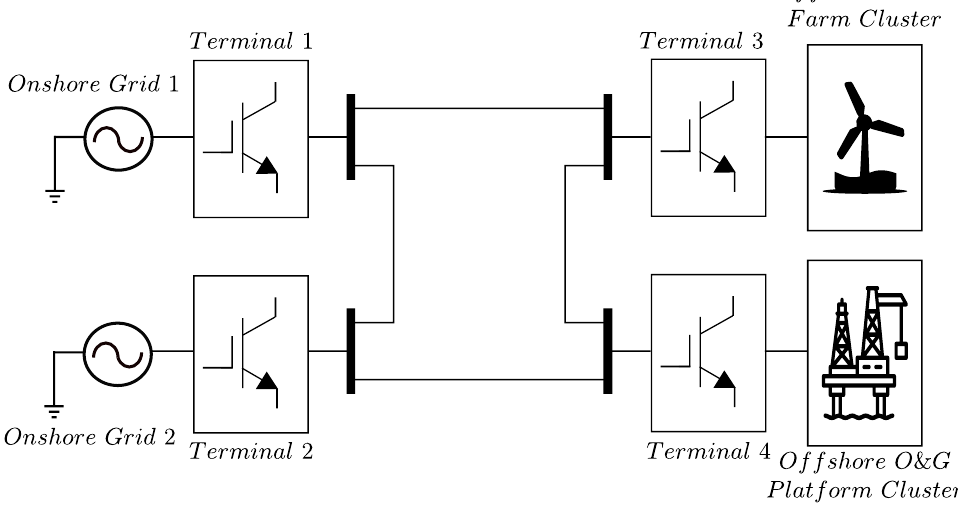
Figure 1. A Multi-Terminal HVDC network for integrating offshore wind power and offshore O&G production units to the onshore grid in two connection